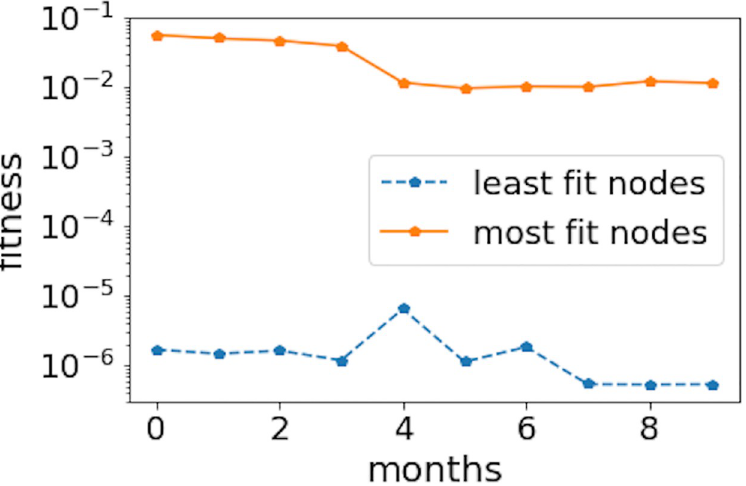
Fig 13. Evolution of the fitness coefficient for the most-fit and the least-fit nodes. The average fitness coefficient was calculated for the most- and least-fit nodes in the beginning of the period and we tracked the change until the end of the period. It can be seen that the fitness coefficient does not change significantly over